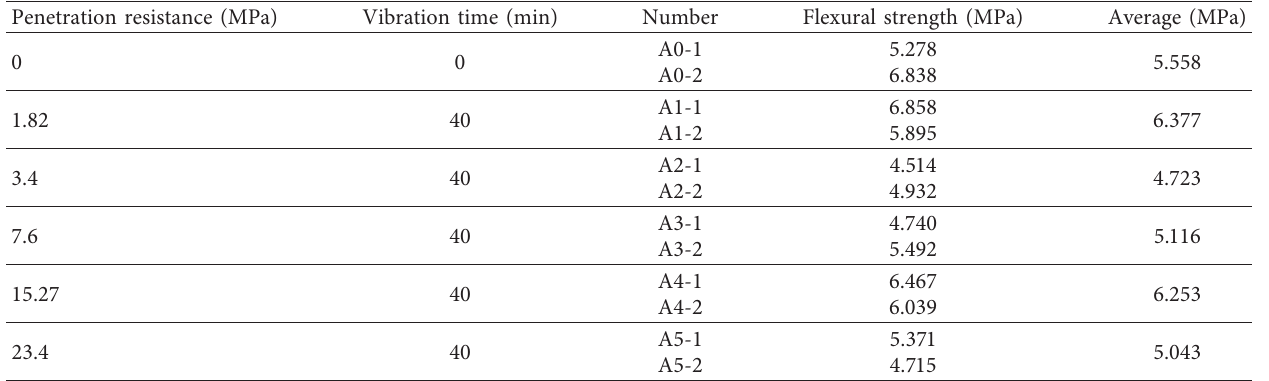
Table 5: Flexural data of plain concrete.